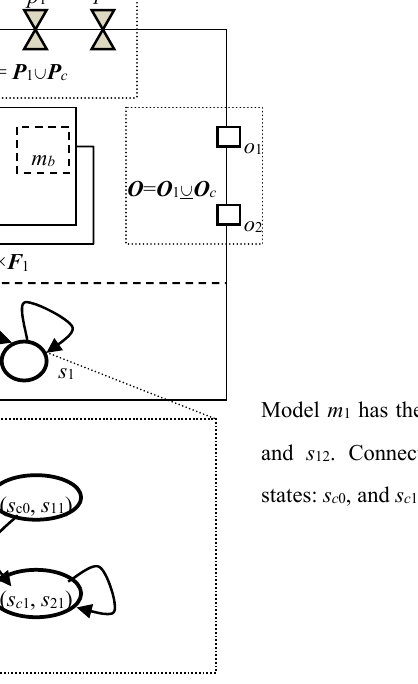
Figure 8. The diagram definition of the Feedback operator.